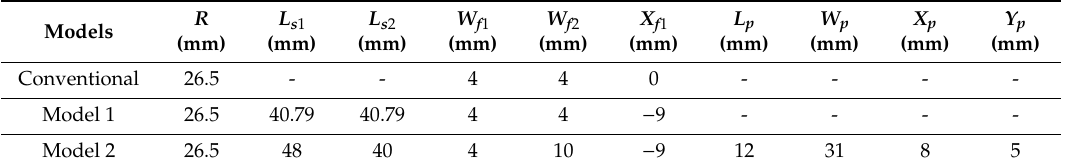
Figure 2. The geometry of model 2. The microstrip feedline is located on the right side, and the edge profile of the antenna is drawn on the bottom. Table 1. Dimensions of CSA models.